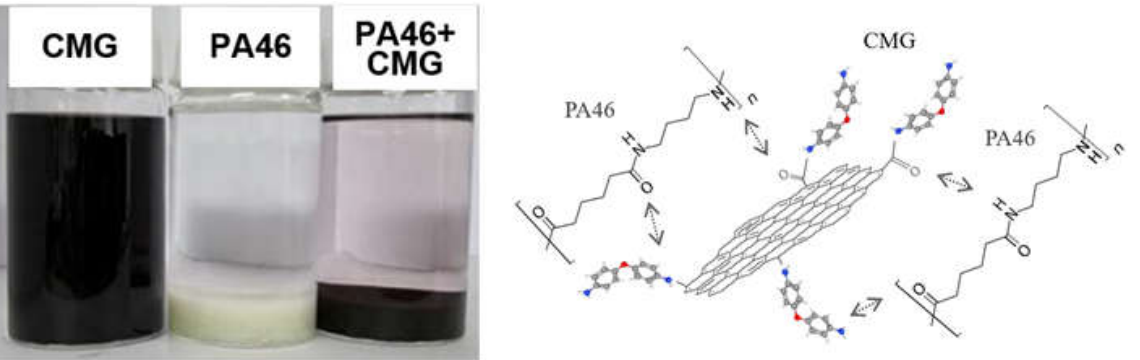
Figure 5. Photographs and schematic representation of the self-adhesion behavior of graphene on PA46 powder.